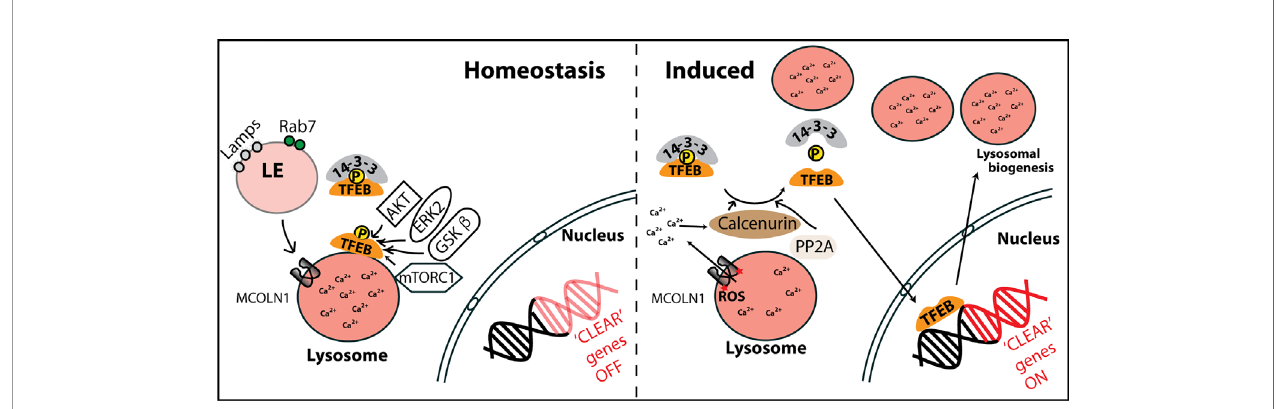
FIGURE 2 | Regulation of cellular lysosomal homeostasis by transcription factor EB (TFEB). In homeostatic conditions, late endosomes (LE) containing lysosomal associated membrane proteins (Lamps) and Rab7 fuse with lysosomes. Multiple kinases including mTORC1, AKT, ERK2, GSK b phosphorylate TFEB, retaining it on the lysosomal surface or sequestered to 14-3-3 chaperons in the cytoplasm. In conditions of lysosomal induction such as starvation, mTORC1 is inactivated and ROS activated MCOLN1 channel releases Ca 2+ from lysosomal lumen to cytoplasm. The release of lysosomal Ca 2+ locally activates calcineurin, which dephosphorylates TFEB. Protein phosphatase 2A (PP2A) is another reported TFEB phosphatase. Dephosphorylated TFEB translocates to the nucleus where it induces transcription of genes containing CLEAR elements, that include several lysosomal genes, eventually resulting in enhanced lysosomal